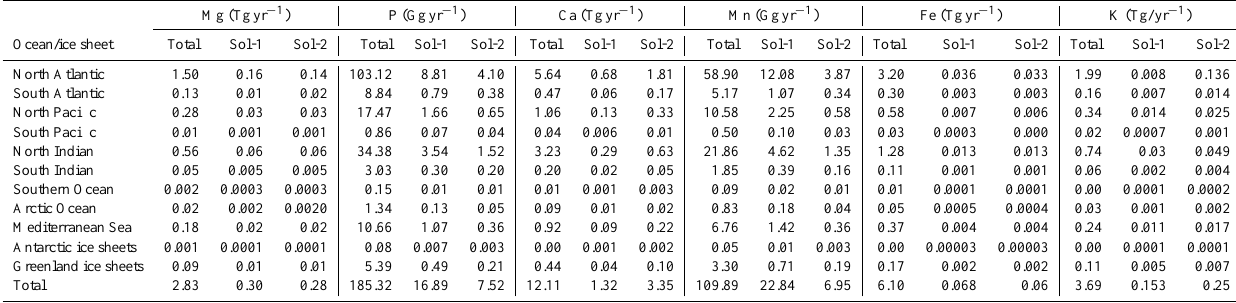
Table 5. Deposition of dust elements into different oceans and ice sheets ∗ .